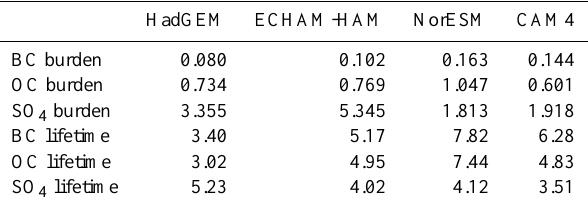
Table 1. Summary of BC, OC and SO 4 burdens (Tg) and lifetimes (days) in the control simulation for each model.